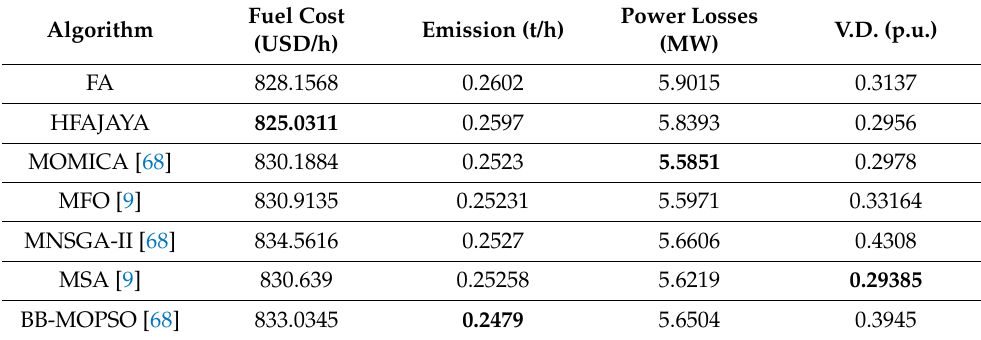
Table 8. The obtained optimal results in the current works for Case